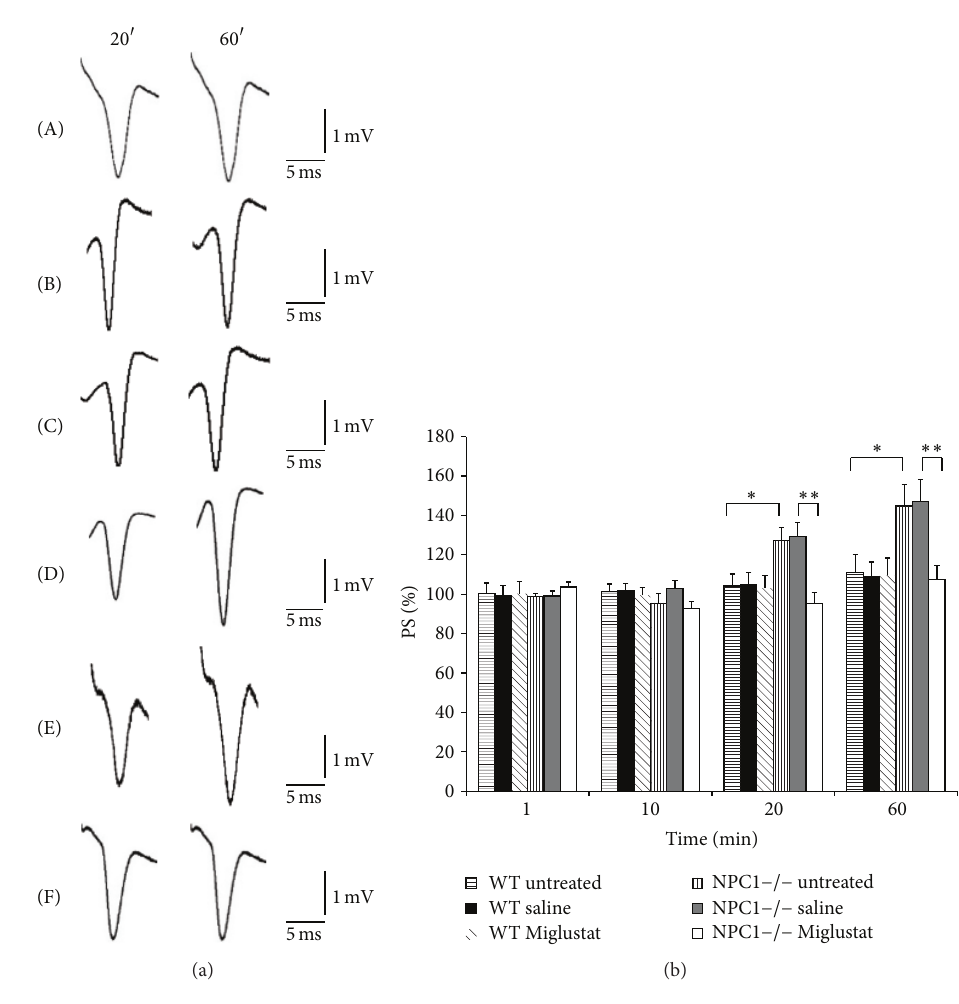
Figure 1: Basal synaptic transmission in CA1 hippocampal subfield in slices obtained from WT and NPC1 − / − mice. (a) Recordings were acquired at times 𝑡 = 20 and 𝑡 = 60 : curves (A), (B), and (C) refer to WT untreated, WT saline treated, and WT Miglustat treated mice slices, whereas curves (D), (E), and (F) represent the PS of NPC1 − / − untreated, NPC1 − / − saline, and NPC1 − / − Miglustat treated mice. (b) % PS amplitude as a function of time is shown in WT untreated (horizontal pattern bar, 𝑛 = 8 ), in WT saline treated (black bar 𝑛 = 5 ), in WT Miglustat treated (diagonal pattern bar, 𝑛 = 5 ), in NPC1 − / − untreated (vertical pattern bar, 𝑛 = 8 ), in NPC1 − / − saline treated (grey bar, 𝑛 = 5 ), and in NPC1 − / − Miglustat treated (white bar, 𝑛 = 11 ) mouse slices at minutes 1, 10, 20, and 60. PS amplitude corresponds to an average of 6 recordings/min. Bars in the plot are means ± SEM of values obtained from different slices. Note significant statistical differences in PS amplitude during 1-hour recording: at 20 min recording 127.1 ± 6 versus 104.1 ± 6.1, respectively, in NPC1 − / − and WT slices of